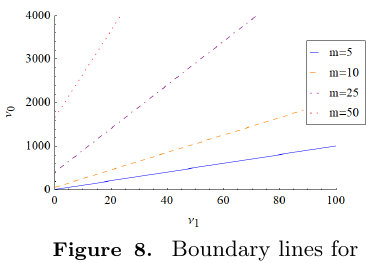
Figure 8. Boundary lines for comparison of T 2 and T 4